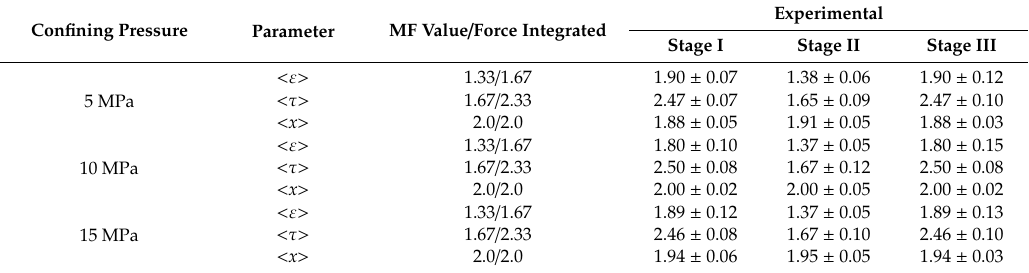
Table 1. Mean exponents’ values for power-law distributions for Stage I, Stage II, and Stage